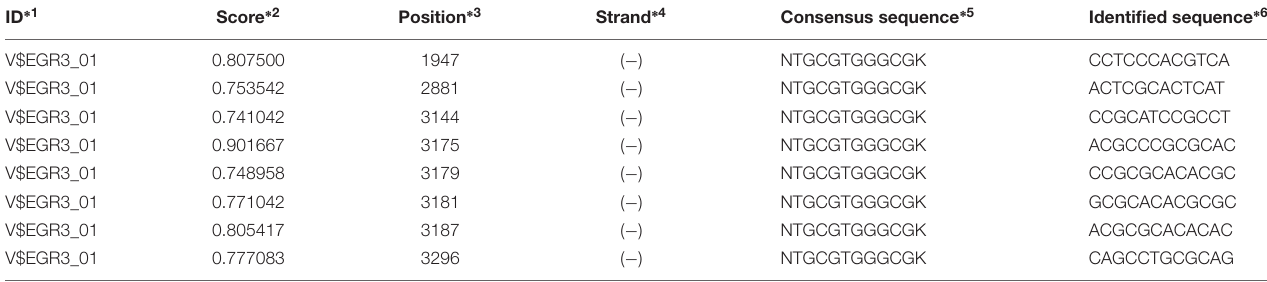
TABLE 1 | EGR3 binding sites identified in the Bdnf promoter using